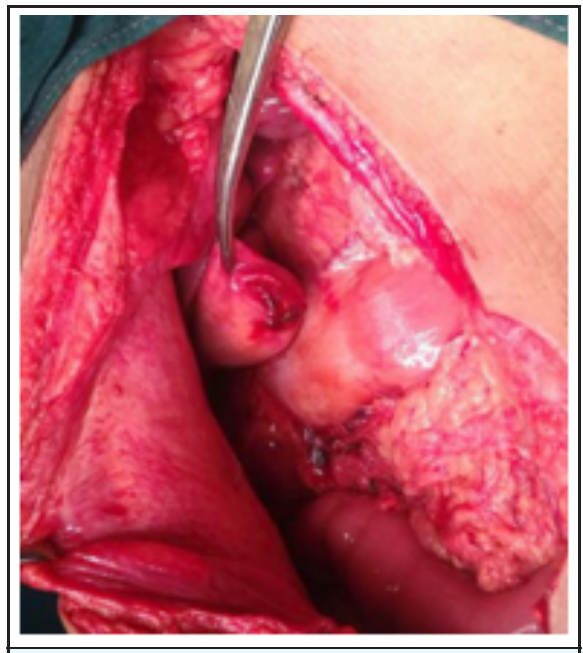
Figure 1. Showing site of perforation of